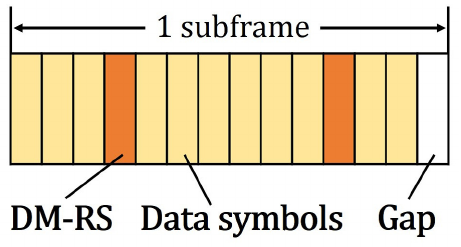
Figure 3. Subframe structure for sidelink for Release 12.